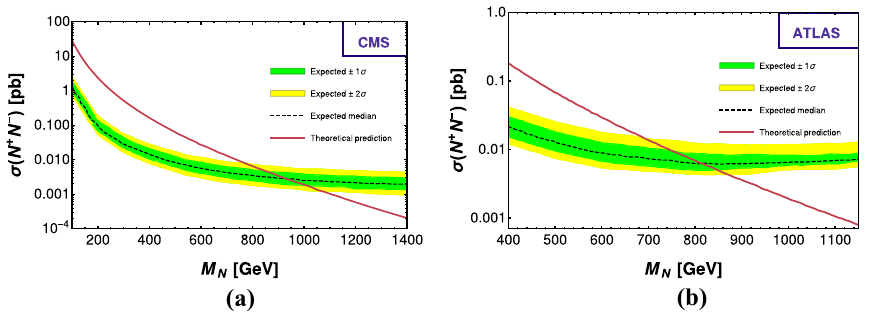
and 2 σ regions respectively. For both the cases the red line denotes the theoretical prediction for the pair production of Type-III fermions